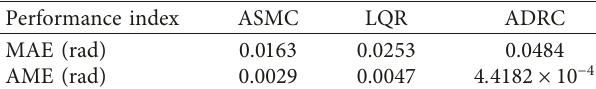
Table 4: Comparison of the pitch tracking performance under the wind speed of 1.6m/s.